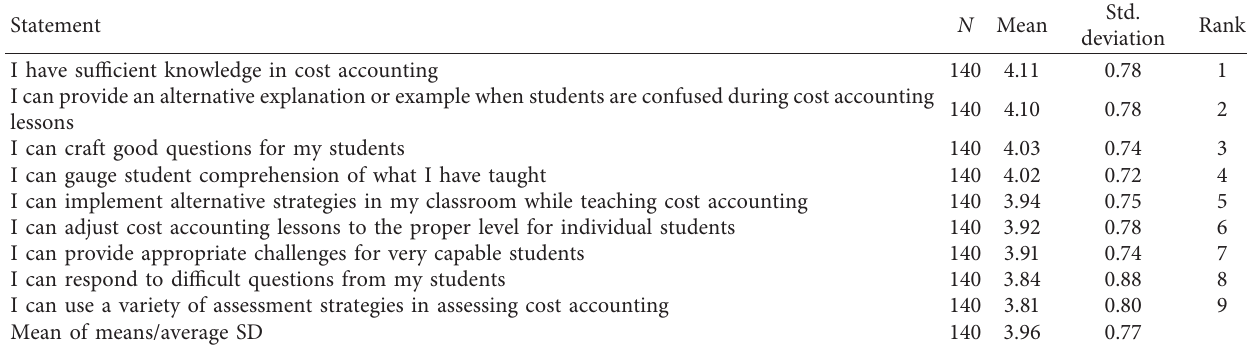
Table 2: Preservice accounting teachers’ self-efficacy in instructional strategies in teaching cost